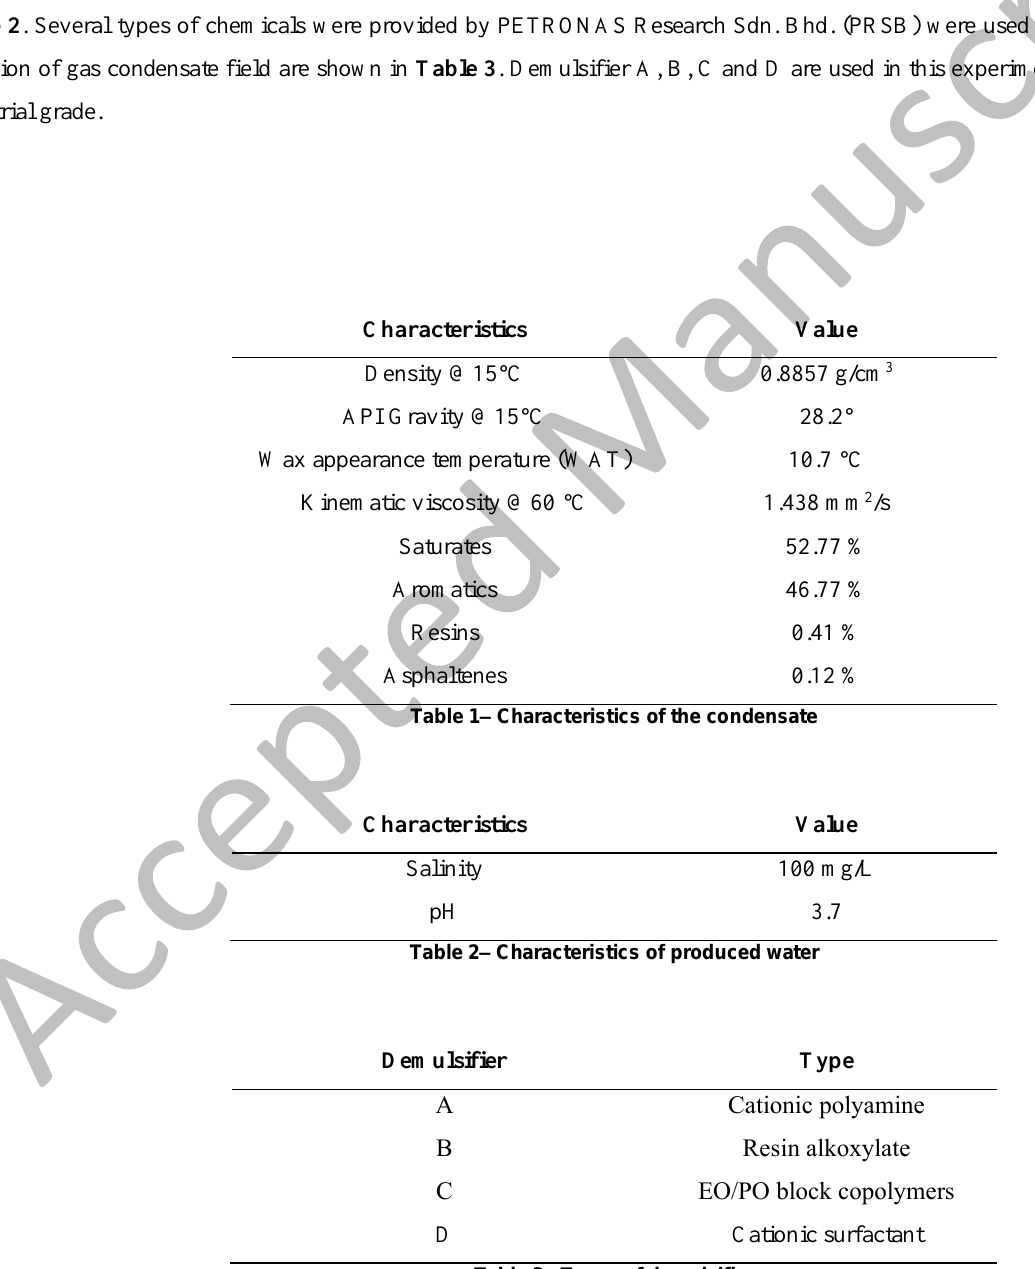
Table 3– Types of